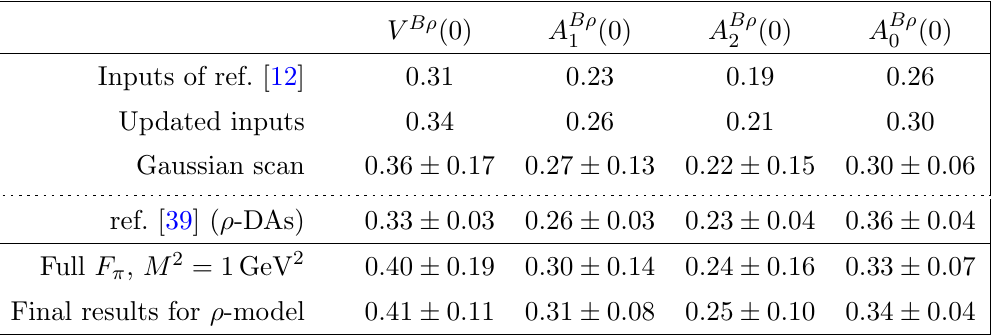
Table 1 . Results for the B ! (cid:26) form factors in the one (cid:26) -resonance model for the B ! (cid:25)(cid:25) form factors. The (cid:12)rst four rows correspond to the zero-width approximation, while the last two rows include (cid:12)nite-width